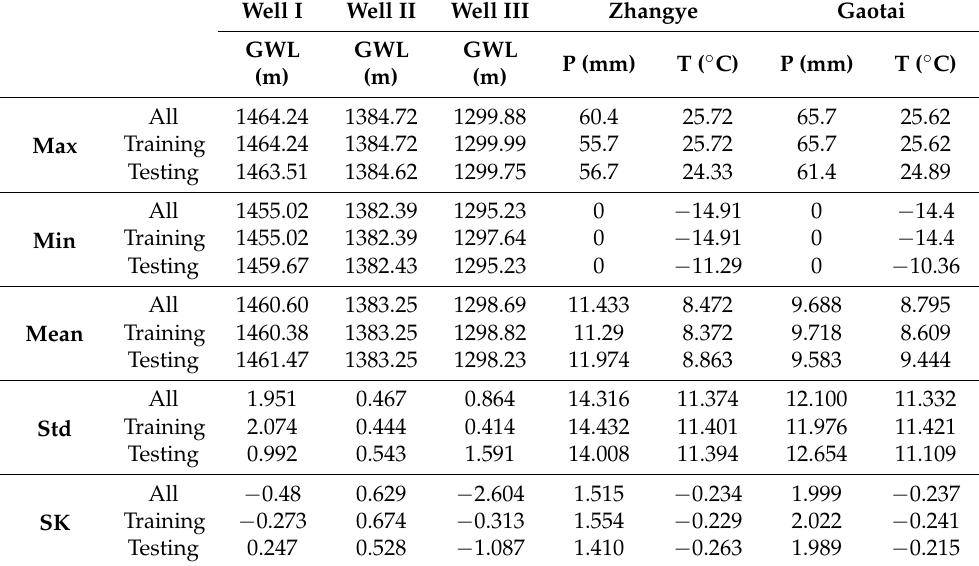
Table 1. Statistical parameters of groundwater level and climate data at three sites.